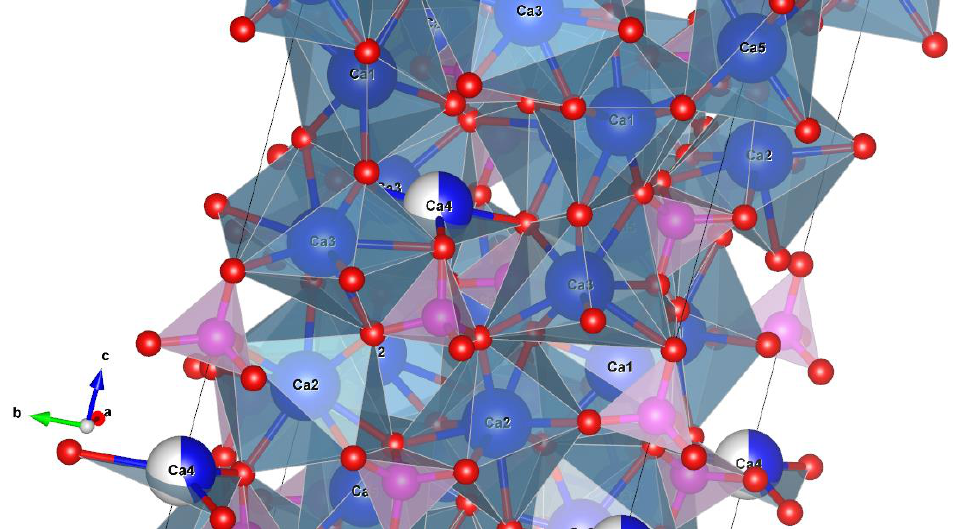
Figure 1. β -TCP crystal structure with the corresponding calcium and phosphorus polyhedra, where red balls — oxygen, blue — calcium, pink — phosphorus.